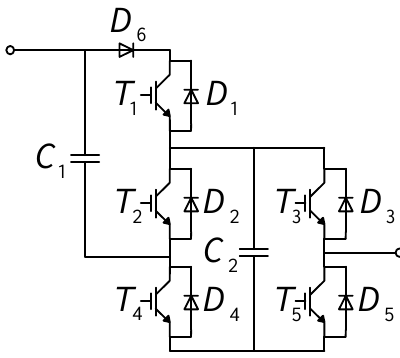
Figure 2. Topology of CHBFBSM.